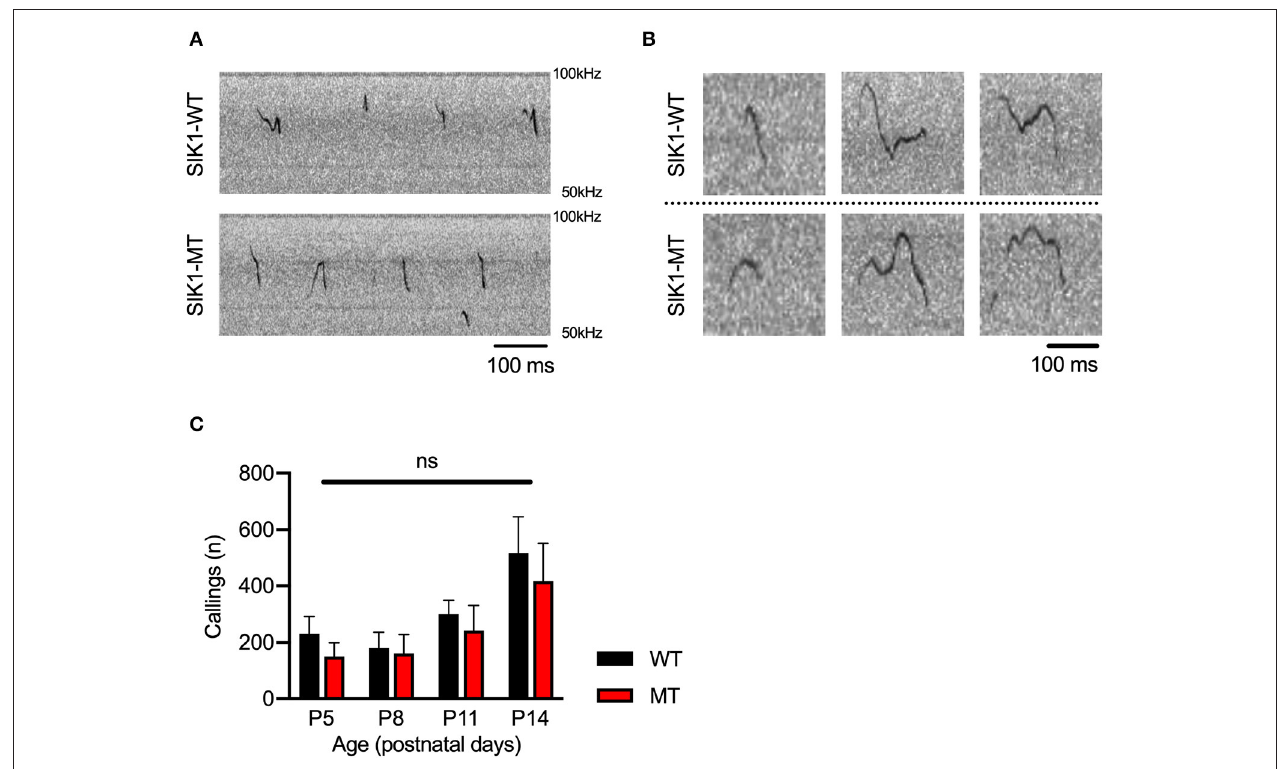
FIGURE 4 | Ultrasonic vocalization was not altered between SIK1-WT and SIK1-MT mice. (A) Representative sonograms recorded from isolated mice (P14) were shown. (B) Both wild-type and mutant mice made a variety of vocalizations during the isolation from their mom. (C) The number of calls was not altered during the developmental stages we examined (no statistical significance was detected by t -test). Eight SIK1-WT and seven SIK1-MT mice were analyzed. Statistical analysis was made by Student’s t